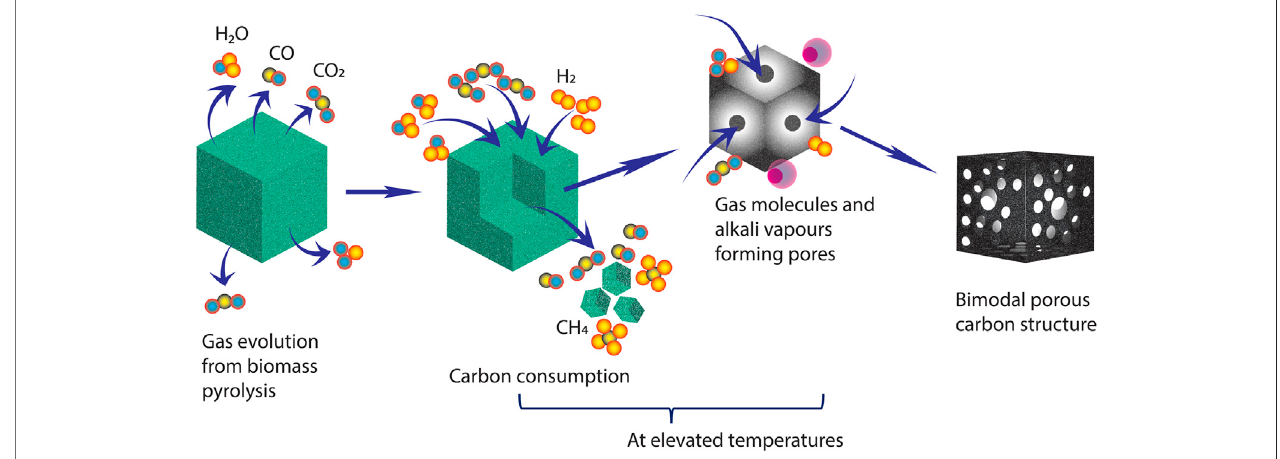
FIGURE 1 | Schematic illustration of the possible mechanism for the formation of a porous carbon structure via self-activation.